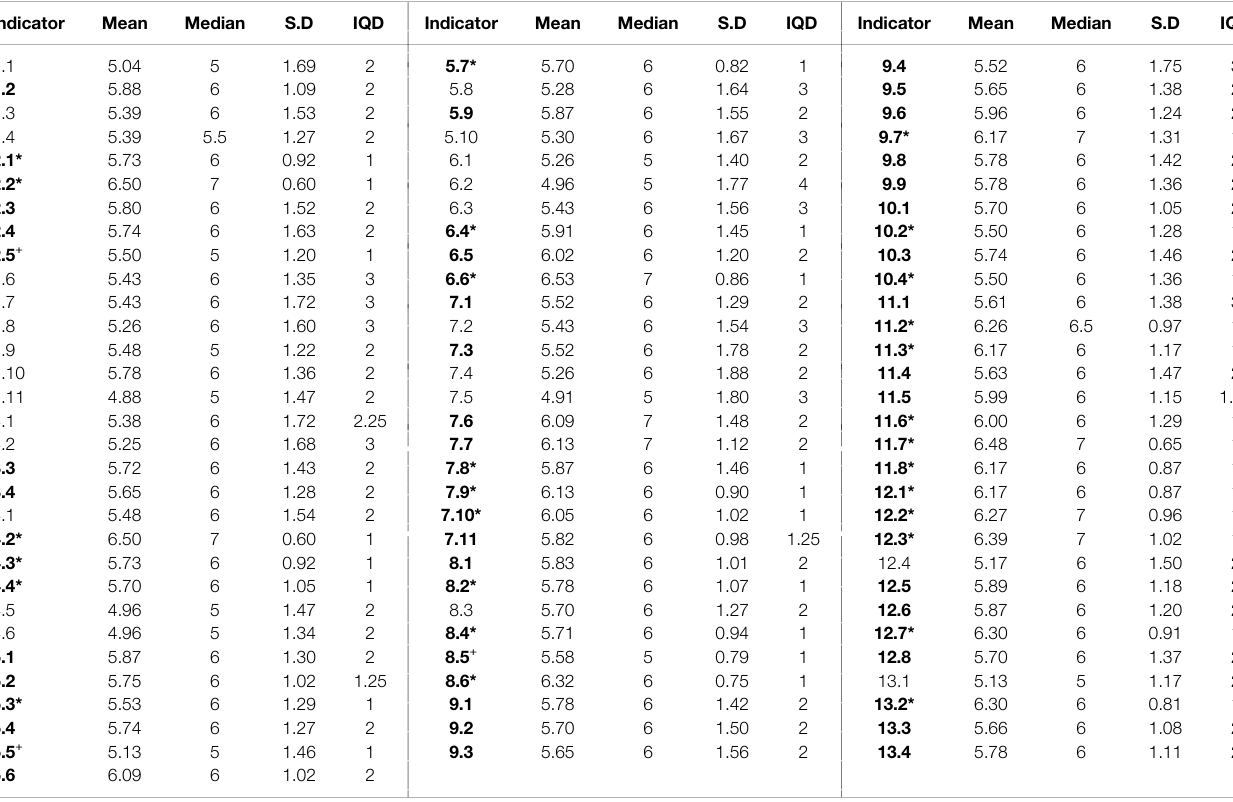
TABLE 6 | Rating of the importance of the 91 indicators and the consensus level.